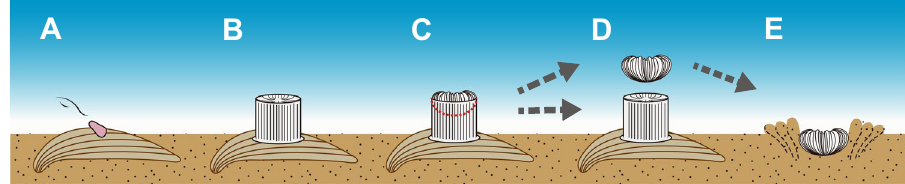
Figure 7. Schematic diagram showing the dimorphic life cycle of the azooxanthellate scleractinian coral Deltocyathoides orientalis . ( A ) Coral planula attaching to shell fragment on soft substrate. ( B ) Anthocaulus. ( C ) Anthocyathus occurring at the upper interior of the anthocaulus. ( D ) Division of anthocyathu from anthocaulus. ( E ) Anthocyathus burrowing into a soft-bottom substrate immediately after